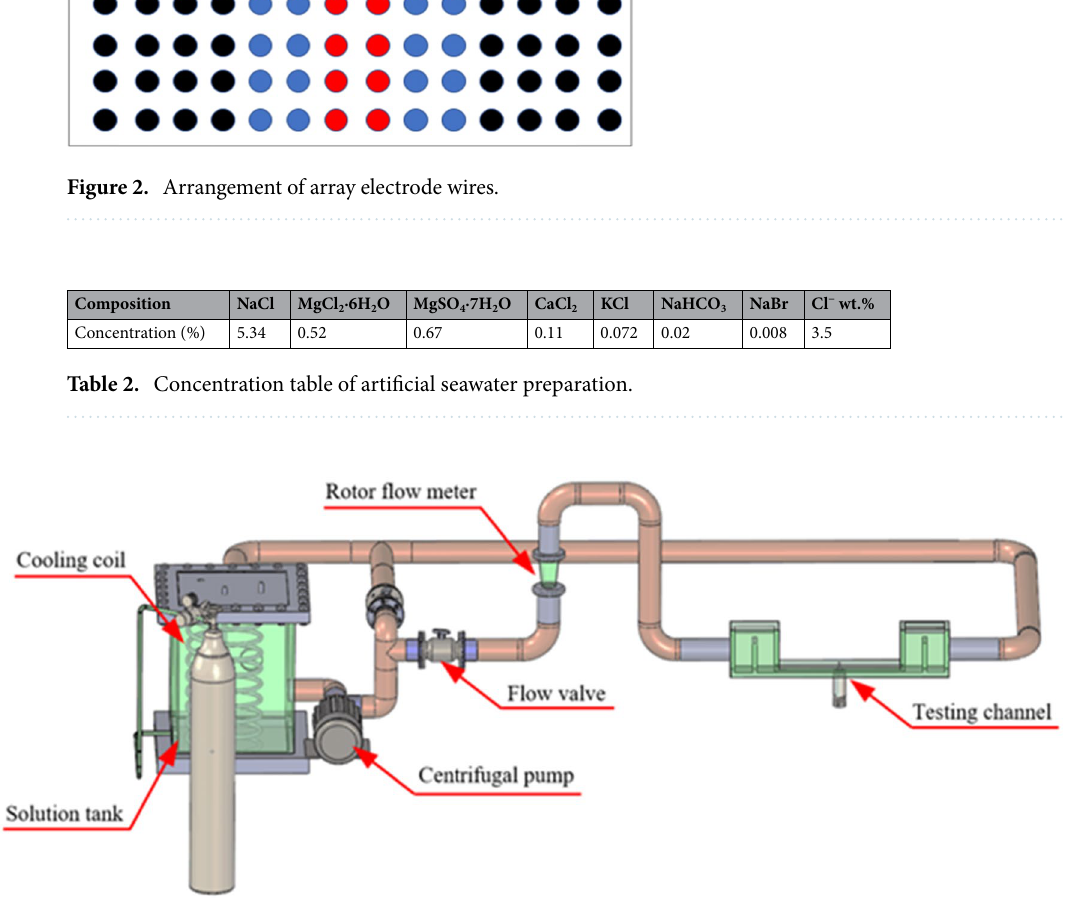
Figure 3. The unidirectional flow accelerated corrosion test circuit.